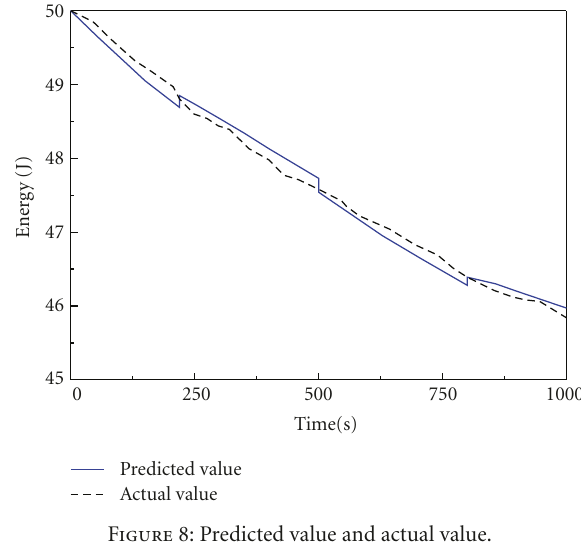
Figure 8: Predicted value and actual value.